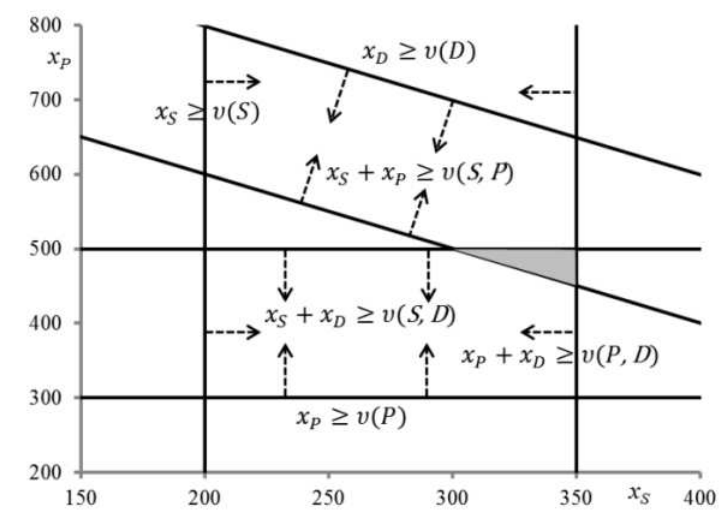
Figure 1. The core of the jazz band game (shaded area) is the set